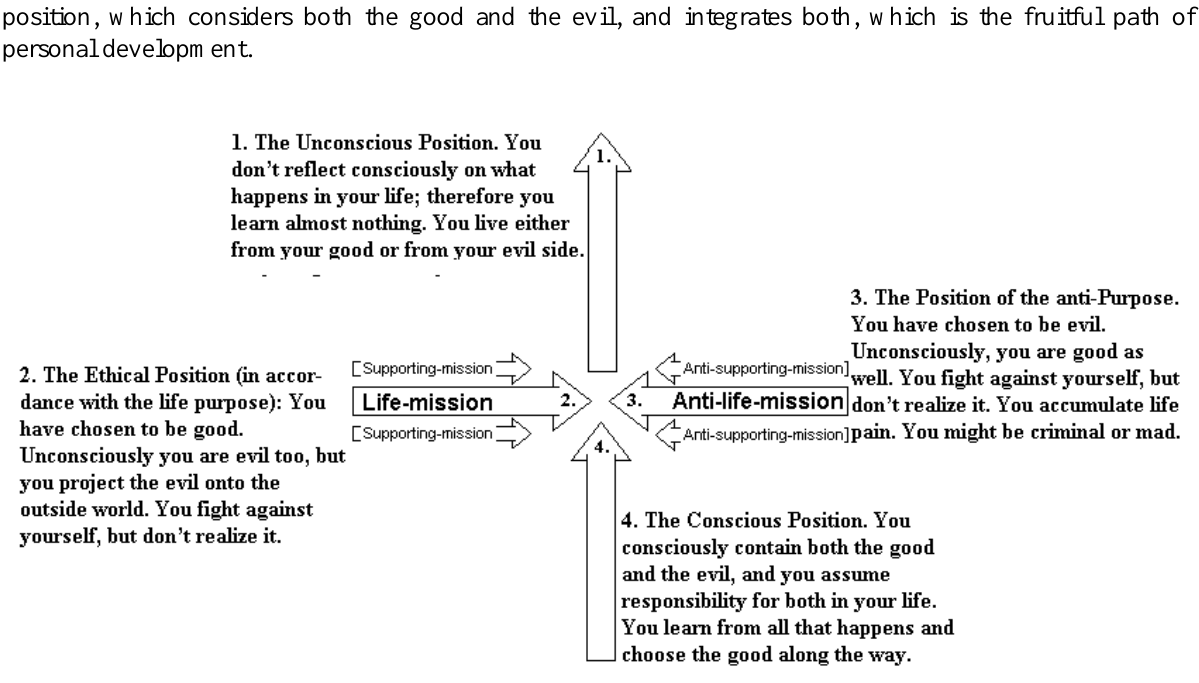
FIGURE 2 . The human being can be unconscious and opportunistic. It can be half-conscious and choose either to be good or bad, or it can be conscious and admit both the good and the evil in itself, attempt to be good in spite of everything, and learn from anything that